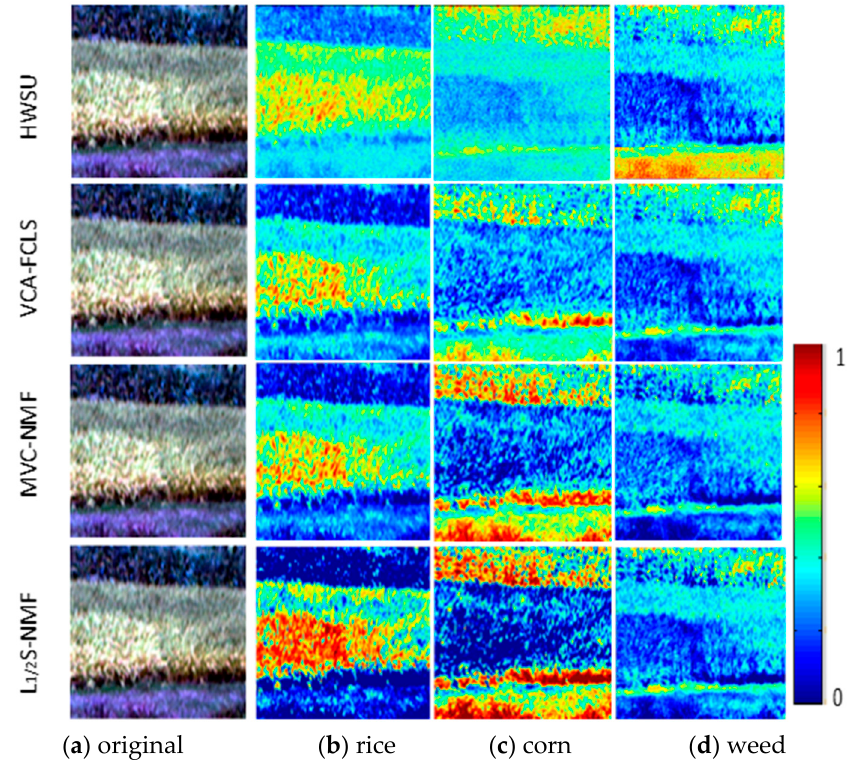
Figure 10. Abundance fraction results of Data 1 estimated by HWSU, VCA-FCLS, MVC-NMF, L 1/2 S-NMF: ( a ) original image, ( b ) rice, ( c ) corn, and ( d ) weed.